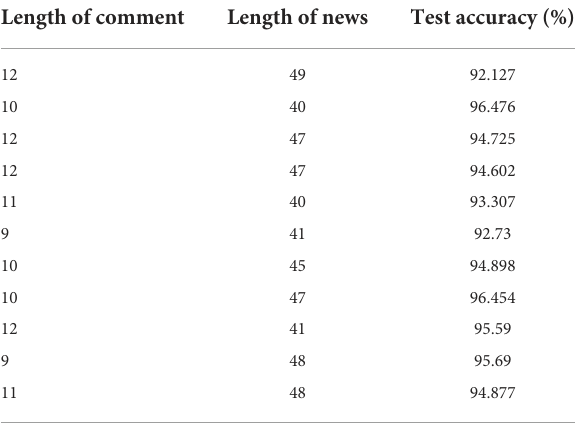
TABLE 4 Text neologism extraction